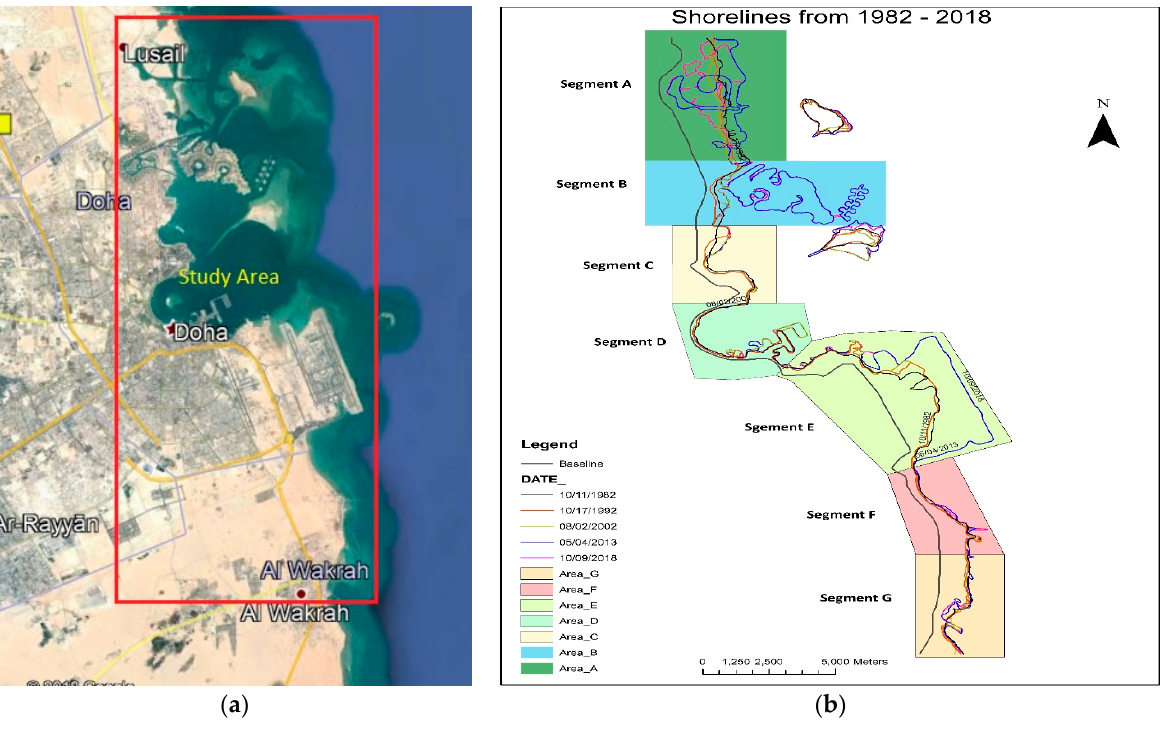
Figure 2. ( a ) Study area, ( b ) study area segments.